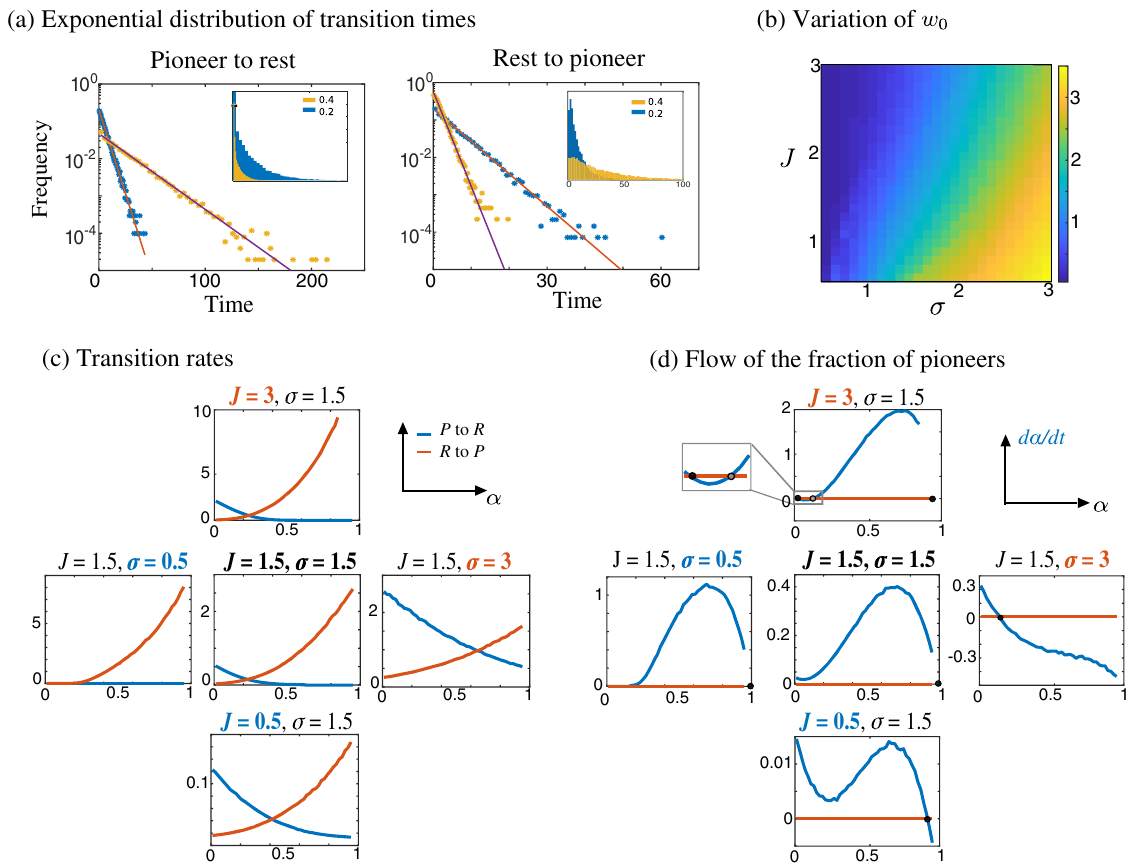
FIG. 3. Stochastic transitions between resting and pioneer states. (a) Histogram of the transition time from pioneer to rest (left) and rest to pioneer (right), in semilogarithmic scale (inset: linear scale) for α ¼ 0 . 2 (blue) or α ¼ 0 . 4 (yellow). The corresponding maximum likelihood fit with an exponential distribution shows an excellent match (solid lines, red, α ¼ 0 . 2 ; purple, α ¼ 0 . 4 ). Parameters as in Fig. 1 with J ¼ 1 . 5 , σ ¼ 1 . 5 , and α ¼ 0 . 2 ; a sample 15 000 independent simulations of Eq. (4) was used. (b) Variation of w 0 as a function of σ and J , computed as the median value of recovery variable at the transition for the original system with n ¼ 4000 neurons. (c) Transition rates obtained from the maximum likelihood estimator with the exponential distribution as a function of α [blue, pioneer to rest; red, rest to pioneer; 15 000 simulations of Eq. (4) for the five situations considered in Fig. 1(a)]. (d) Flow of the fraction of pioneers [right-hand side of Eq. (5), blue curve versus 0 in